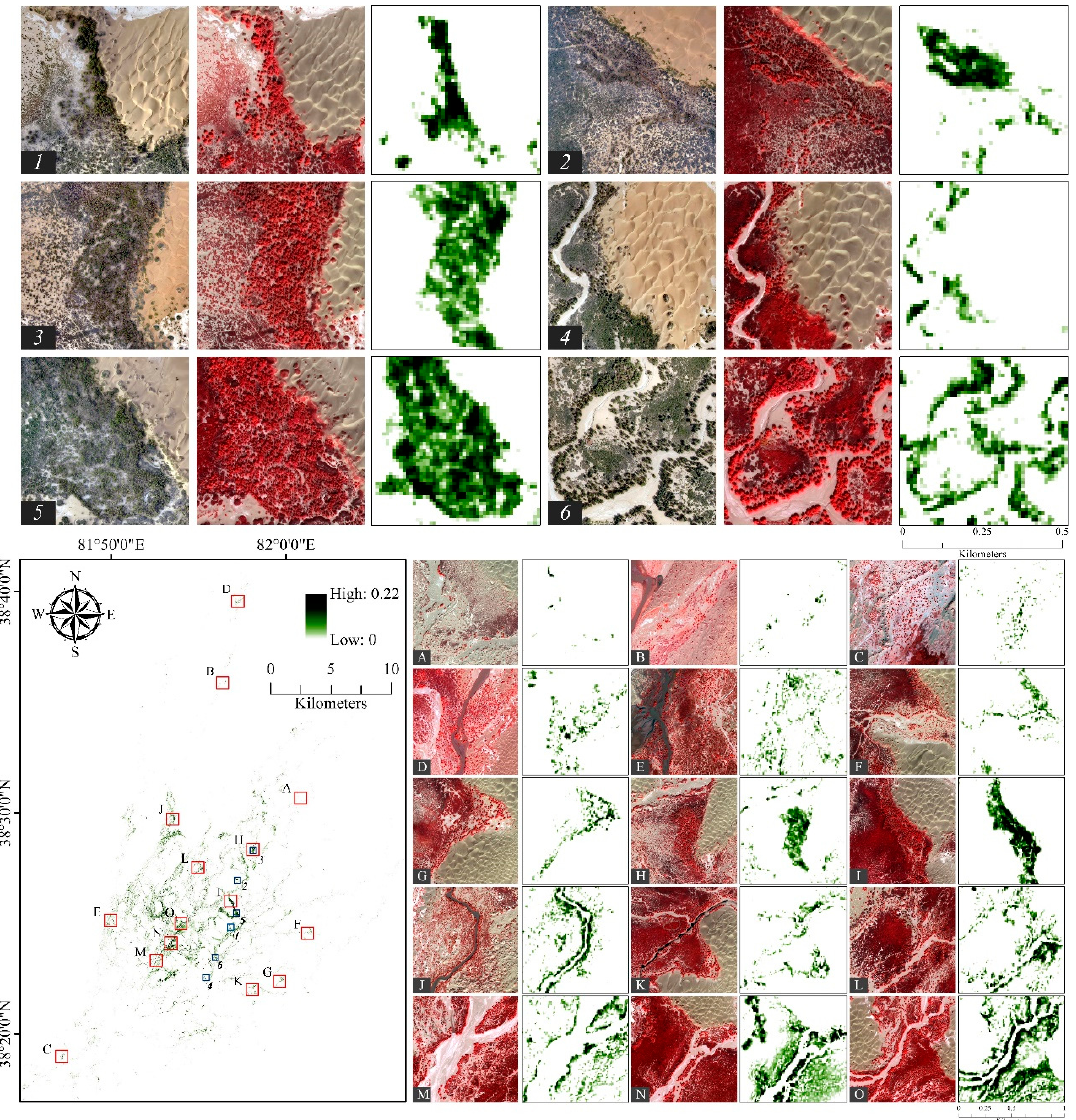
Figure 7. Distribution map of Populus euphratica : ( A – C ) sparse area of Populus euphratica ; ( D – F ) evenly distributed areas of Populus euphratica ; ( G – I ) dense areas of Populus euphratica ; ( J – L ) tributary areas; and ( M – O ) main channel area . Table 6. Confusion matrix classification results using the combined IRECI index and maximum entropy.